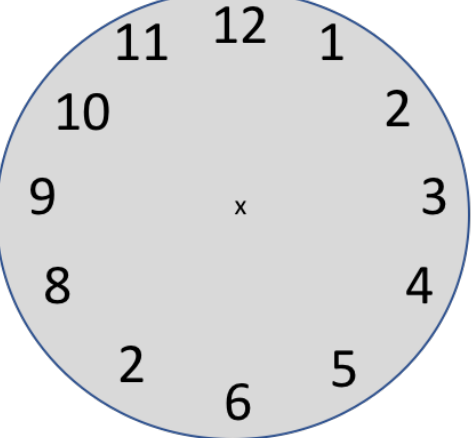
Figure 4. Fixate on the ‘x’ at the center and find the incorrect number .